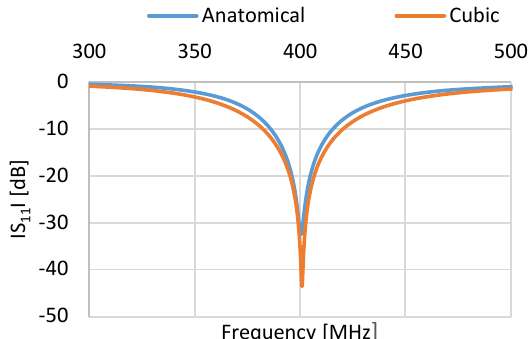
Figure 6. Reflection coefficient frequency response of the on- body antenna in the free space and in the anatomical model in Figure 4. Reflection coefficient frequency response of the the MedRadio band. ingestible antenna inside the cubic model and the anatomical model.